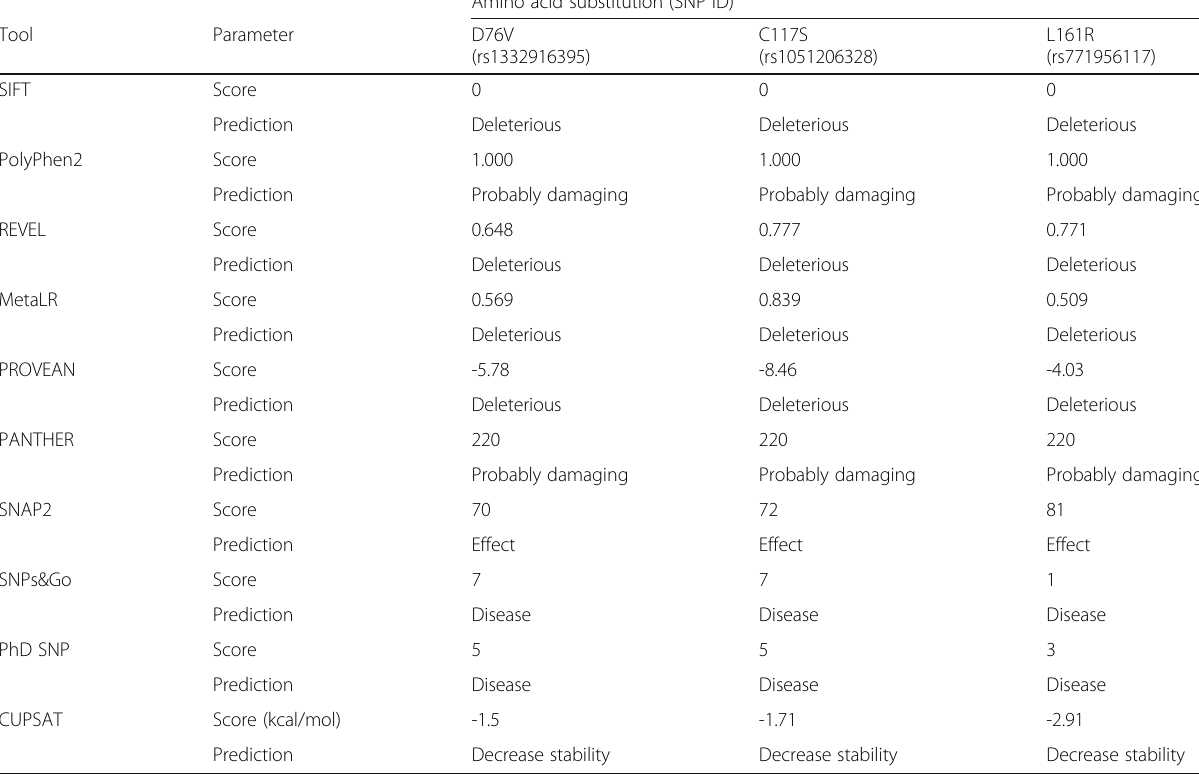
Table 2 List of the completely deleterious variants observed in the human LEP gene by extensive prediction approach